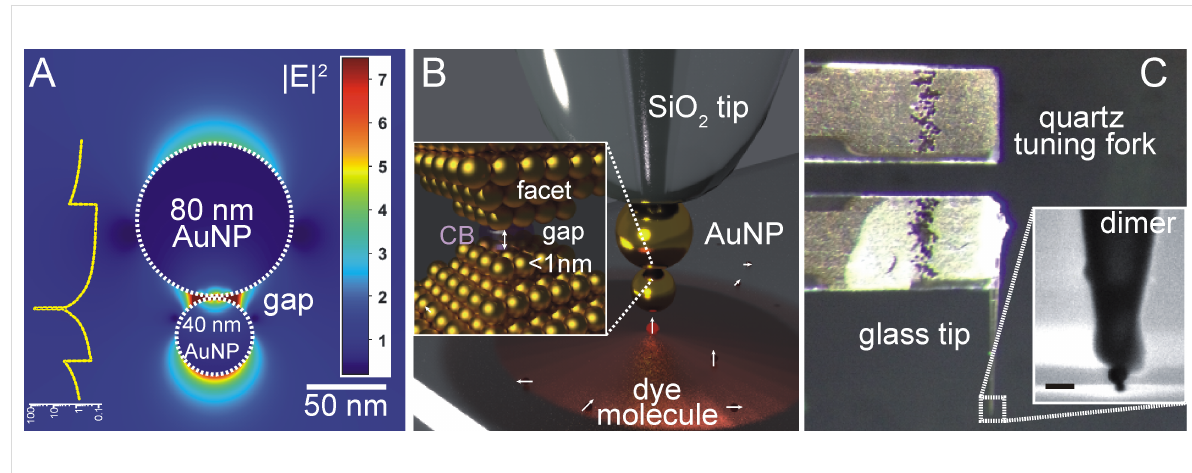
Figure 1: Tip-supported dumbbell antenna. (a) Calculated electromagnetic field distribution of a 80–40 nm AuNP dimer antenna with a gap size of 1 nm. (B) Schematic representation of a dimer antenna formed of spherical AuNPs attached to a sharply pointed glass tip. Inset: Magnification to the gap region showing the aligned CB[ n ]s on the NP surfaces, which results in a sub-nanometer gap distance. (C) Macroscale picture of a glass tip at- tached to a piezoelectric quartz tuning fork acting as a force sensor. Inset: SEM image of the CB[ n ] mediated dimer antenna attached to the pointed end of the glass tip. Scale bar: 100